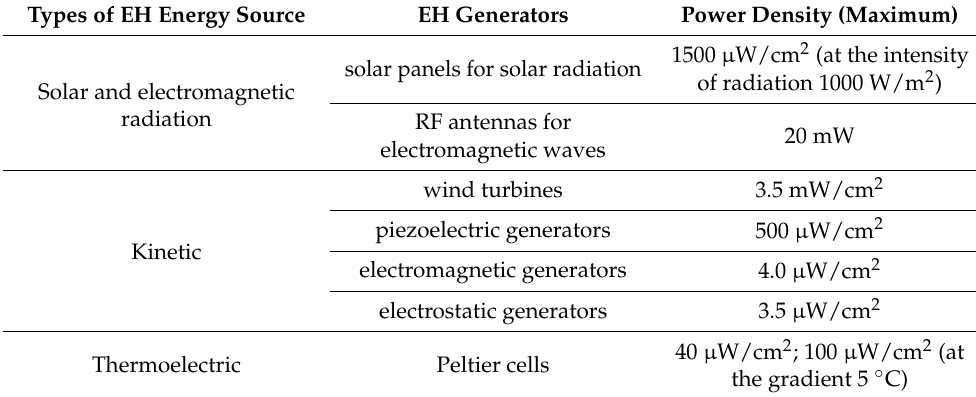
Table 2. List of average energy densities for the discussed